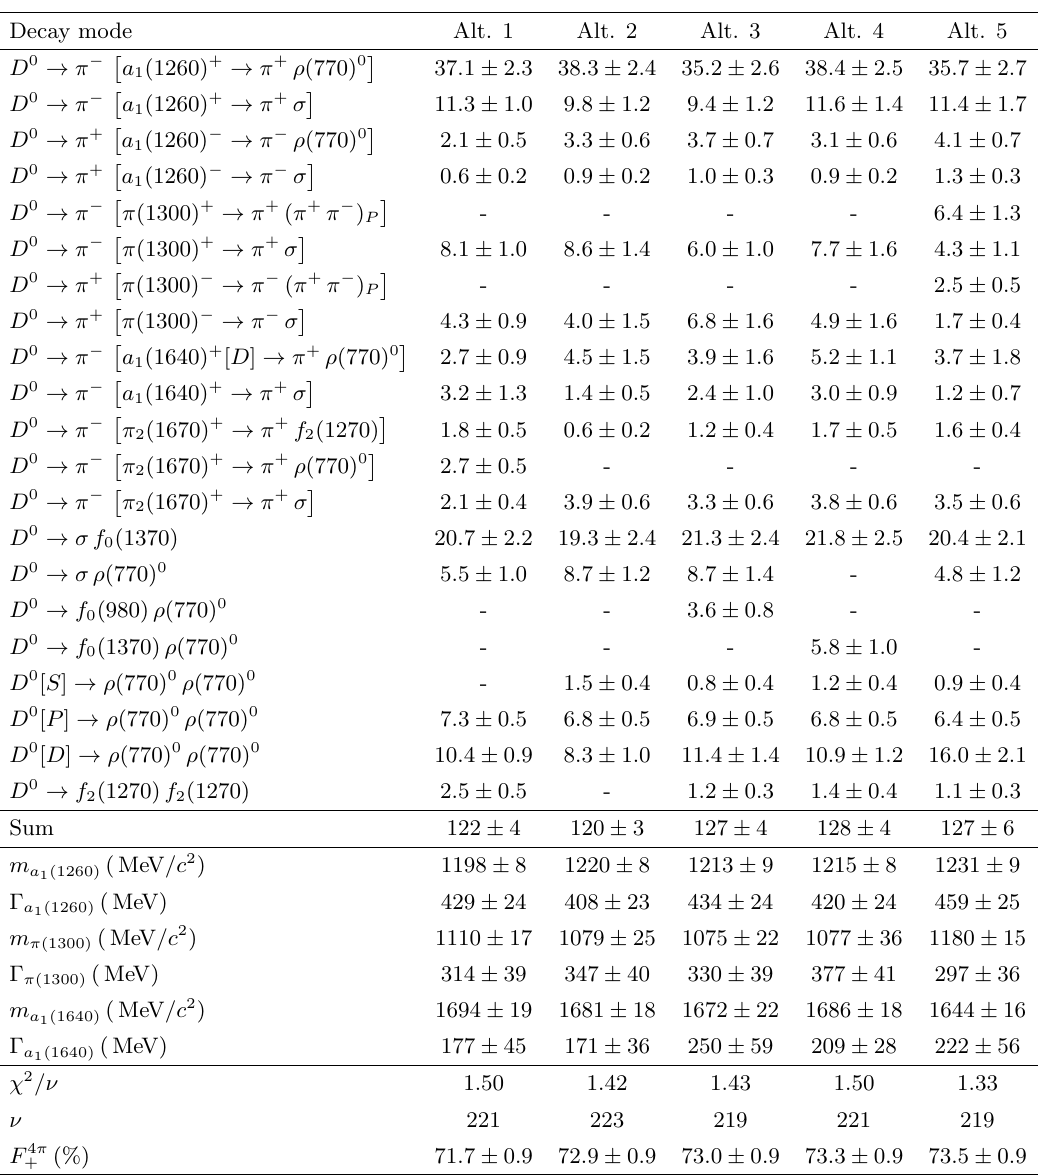
Table 19 . Fit fractions in percent for each component of various alternative models for D 0 ! (cid:25) + (cid:25) (cid:0) (cid:25) + (cid:25) (cid:0) based on (cid:12)t quality. Resonance parameters, F 4 (cid:25) tainties are statistical